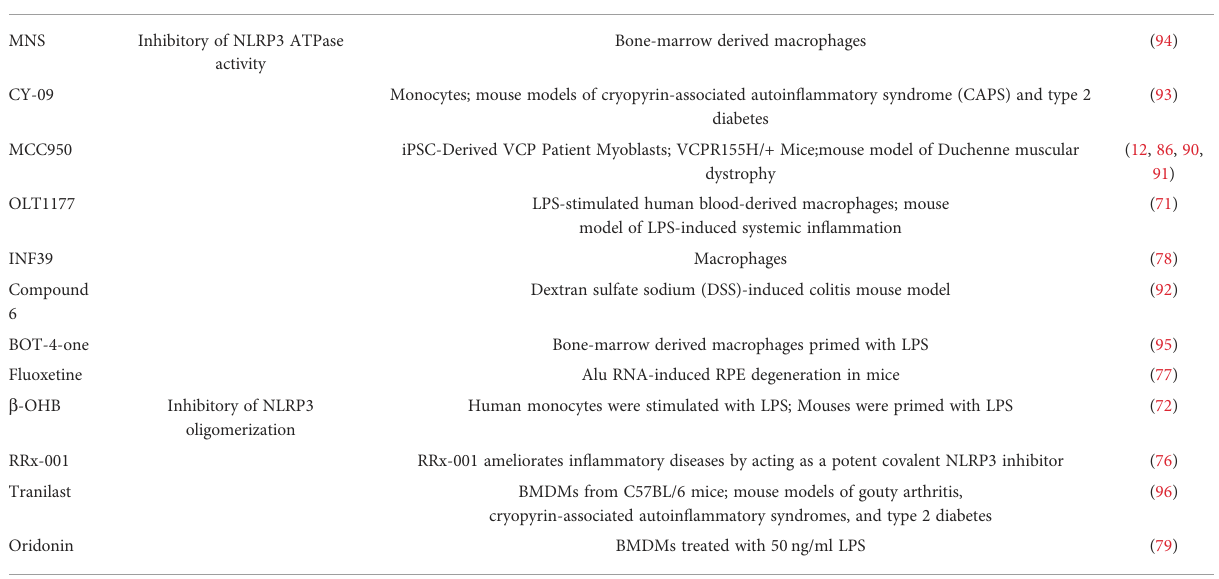
TABLE 1 Direct NLRP3 inhibitors and their